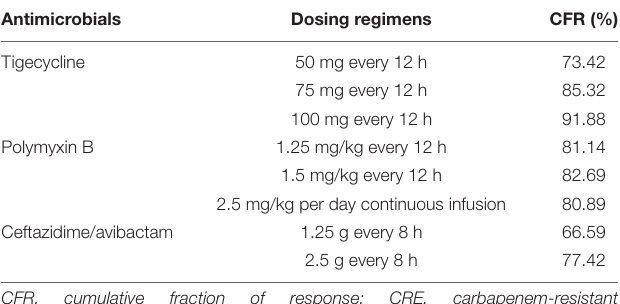
TABLE 6 | CFR values for three antibiotics against CRE.